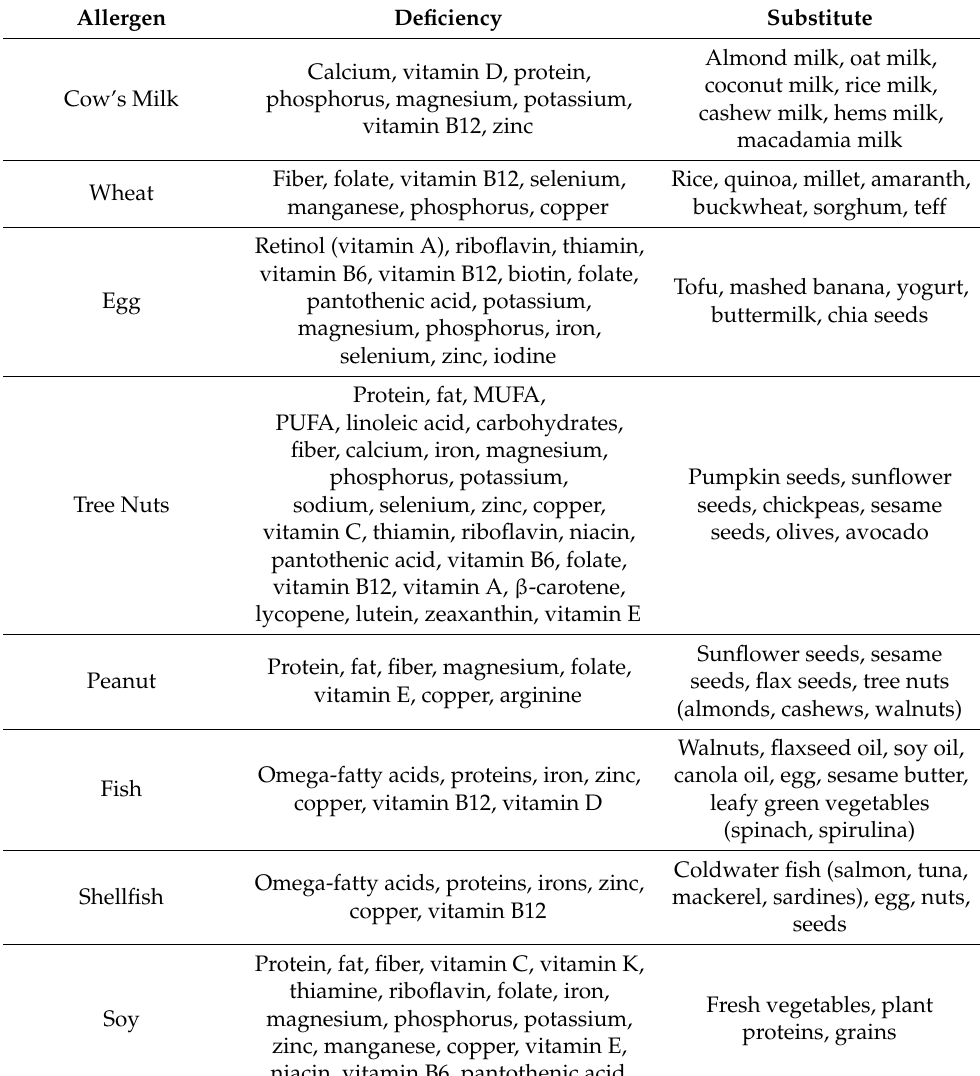
Table 4. Nutritional gaps and possible replacement strategies in diets excluding the eight most common IgE-dependent food